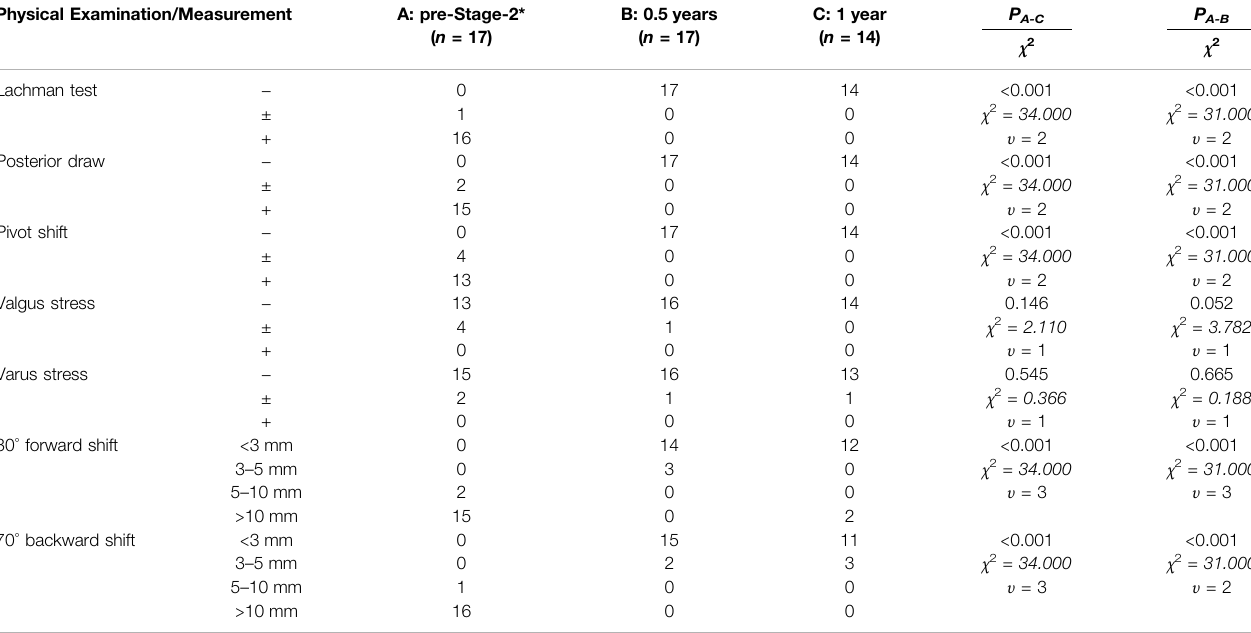
TABLE 2 | Clinical assessments of knee stability before stage-2 operation and during the follow-ups. Physical